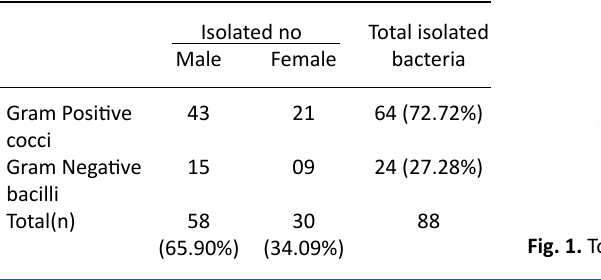
Table 1. Number of Isolated Bacteria Isolated no Total isolated Female